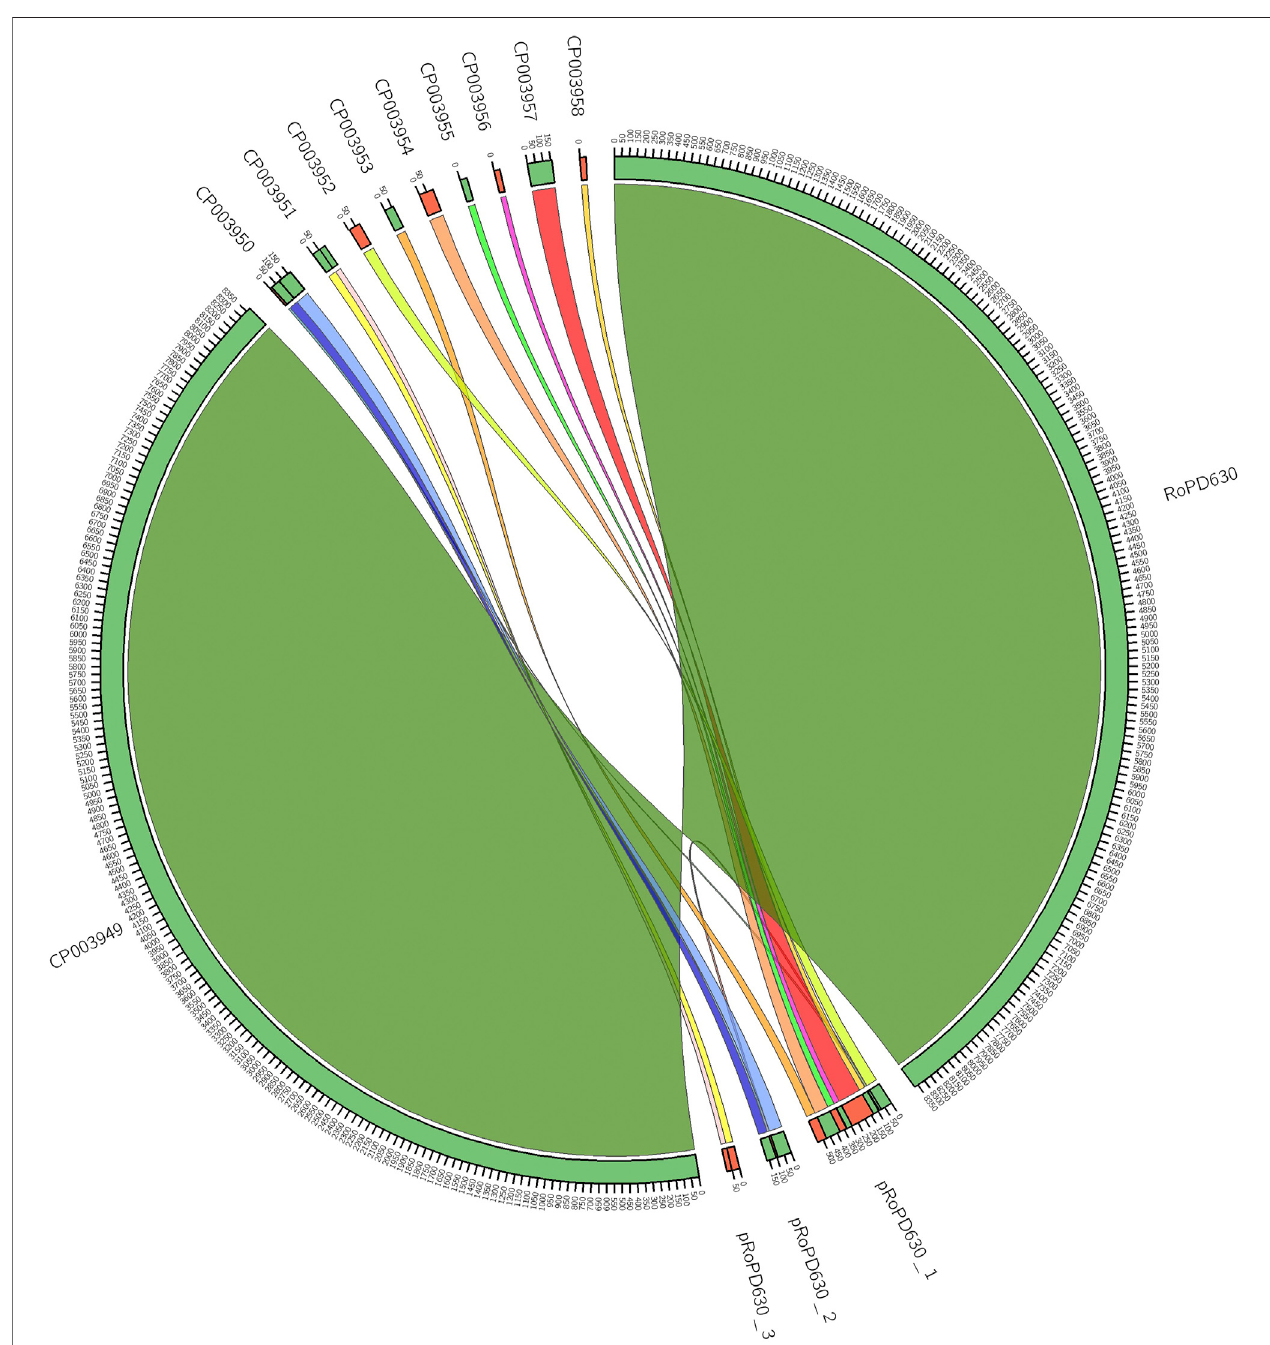
FIGURE 1 | Inferred synteny between IBP_PD630 and FABIT_PD630 assemblies. A minimum synteny block of 10 Kb was selected.